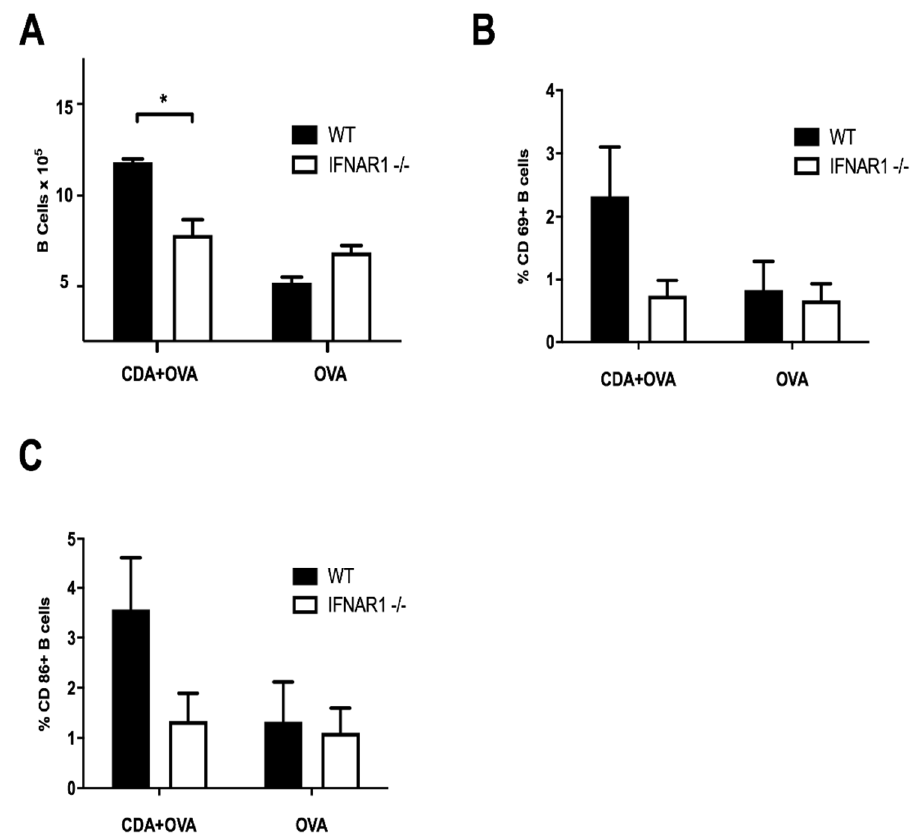
Figure 3. Neonatal vaccination with CDA induces B cell activation and maturation. Percentage of activated B cells after a prime-dose in neonatal mice. ( A ) Number of B cells alive after restimulation. ( B ) Frequency of CD69 + B cells or ( C ) CD86 + B cells from WT (B6) or IFNAR1 − / − (IFN receptor KO) mice vaccinated with CDA + OVA or OVA alone to determine the dependence of B cell maturation on the CDA induced IFN- α / β . Results are from one representative experiment out of three independent experiments consisting of 3–5 mice per group. Differences are significant when marked (*), otherwise not significant by a non-paired Student’s t -test ( p ≤